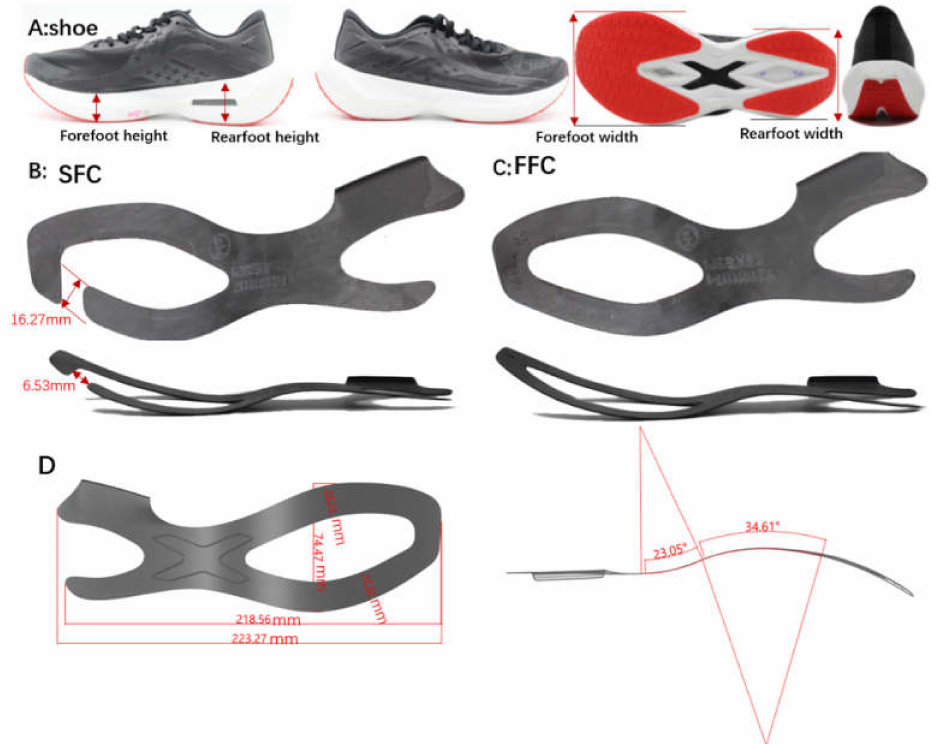
Figure 1. ( A ): Experiment shoe (Forefoot height: vertical thickness at 12% of external length, Rearfoot height: vertical thickness at 75% of external length, offset: offset = rearfoot height − forefoot height); ( B ): the forefoot area of carbon fiber plate (carbon fiber plate was made up of 63 % carbon fiber and 37% epoxy resin fiber) was designed to a segment construction inserted to midsole (SFC), ( C ): the forefoot area of carbon fiber plate was designed to a full construction inserted to midsole (FFC)); ( D ): the information about the geometry and dimensions of the carbon